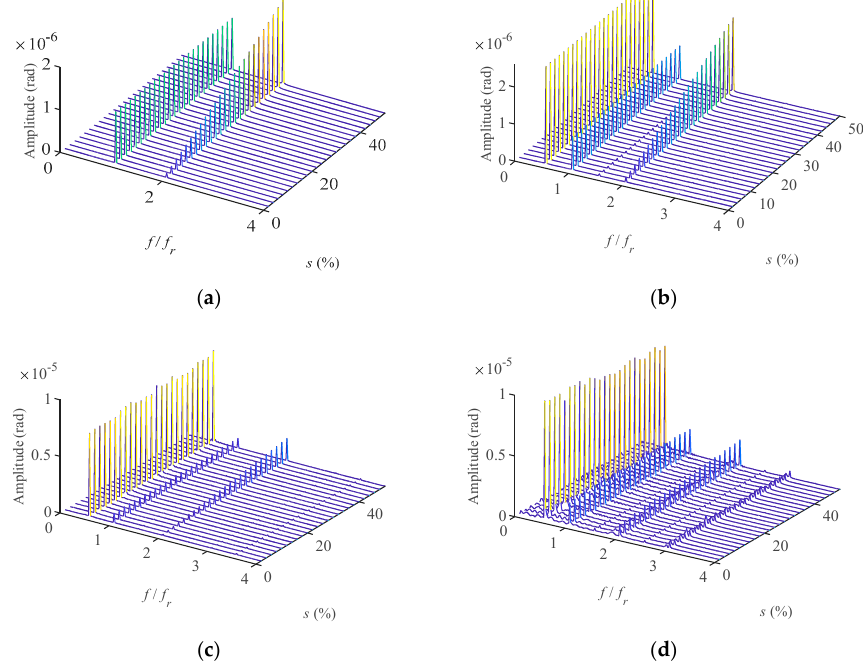
Figure 13. Waterfall diagram of vibration response varying with s at different speeds: ( a ) ω = 500 rad/s; ( b ) ω = 800 rad/s; ( c ) ω = 1100 rad/s; ( d ) ω = 1800